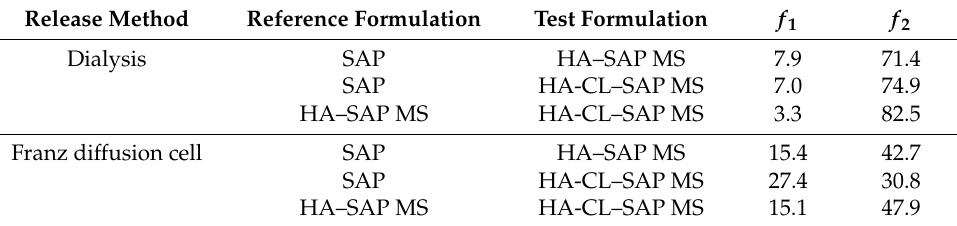
Figure 8. Diffusion profile of SAP as free drug and release profile of SAP from HA and HA-CL MS investigated by dialysis ( a ) and Franz diffusion cells ( b ). Table 3. Similarity factors ( f 2 ) and difference factors ( f 1 ) for free SAP and MS formulations